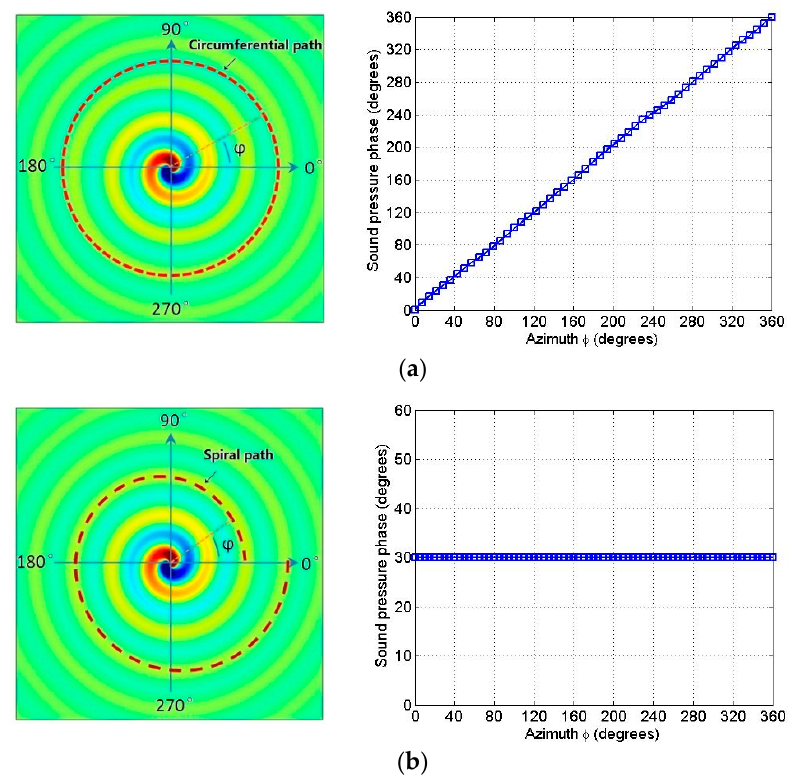
Figure 10. ( a ) The emulation phase angle of the spiral wave as a function of the physical azimuthal angle φ along the circular path at the resonance frequency 10.5 kHz; ( b ) the emulation phase angle of the spiral wave as a constant of the physical azimuthal angle φ along the spiral line path at the resonance frequency 10.5 kHz.